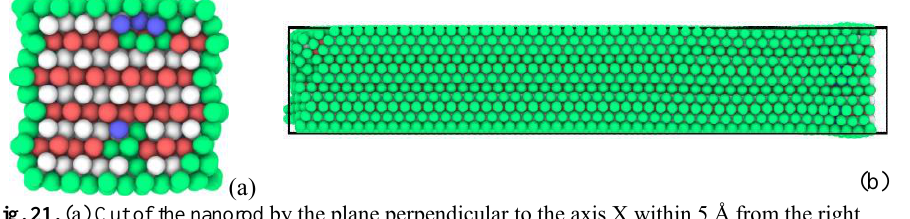
Fig. 21. (а) Cut of the nanorod by the plane perpendicular to the axis X within 5 Å from the right edge at the time instant 2 ps. Green shows the surface atoms and other structureless ones; white shows the atoms forming the FCC lattice; blue shows the atoms forming the BCC lattice; red shows the atoms forming the FCCP lattice. (b) Outlook of the nanorod in plane XZ, black line – the whole system size, the cut area is to the right within 5 Å from the right edge.